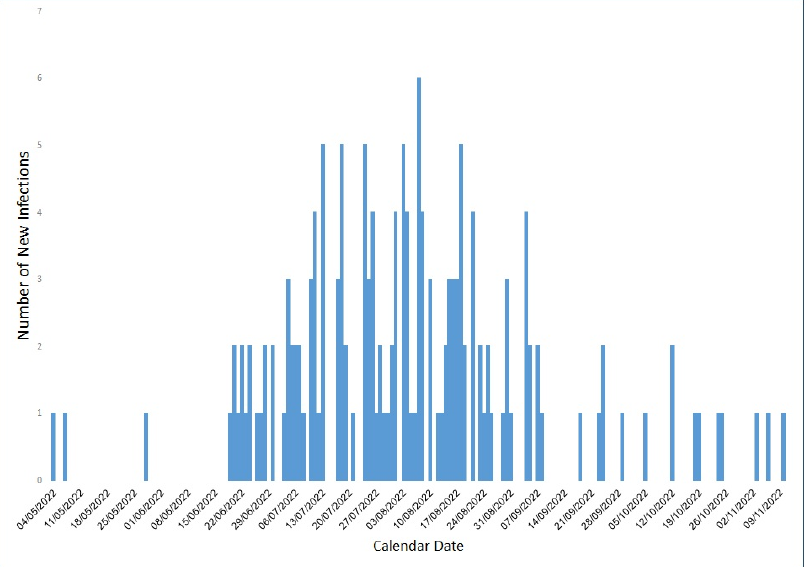
Figure 1. Number of MHS members infected with Mpox between May and November 2022, by dates. Table 1. Characteristics of individuals infected with Mpox between 4 May 2022 and 10 November 2022.